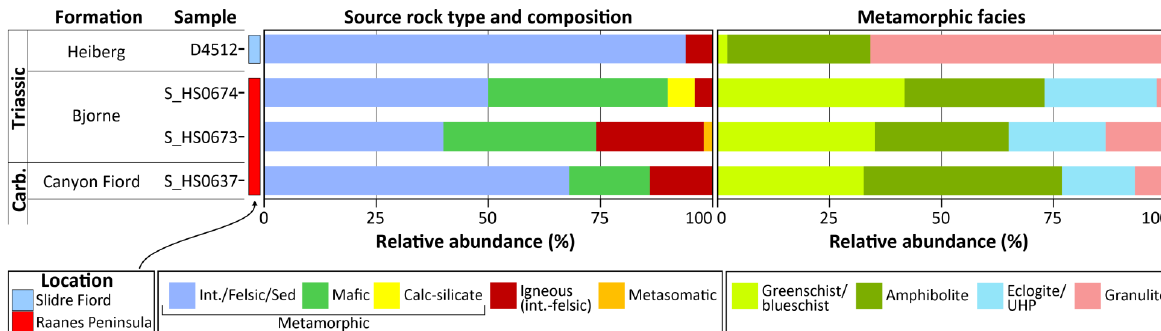
Figure 7. Bar chart summarising the likely source rocks from which the garnet grains were derived. Grains were classified based on their major element chemistry following Schönig et al. [95]. Fifty grains were analysed from each sample. Int = intermediate; Sed = sedimentary; UHP = ultra-high pressure.